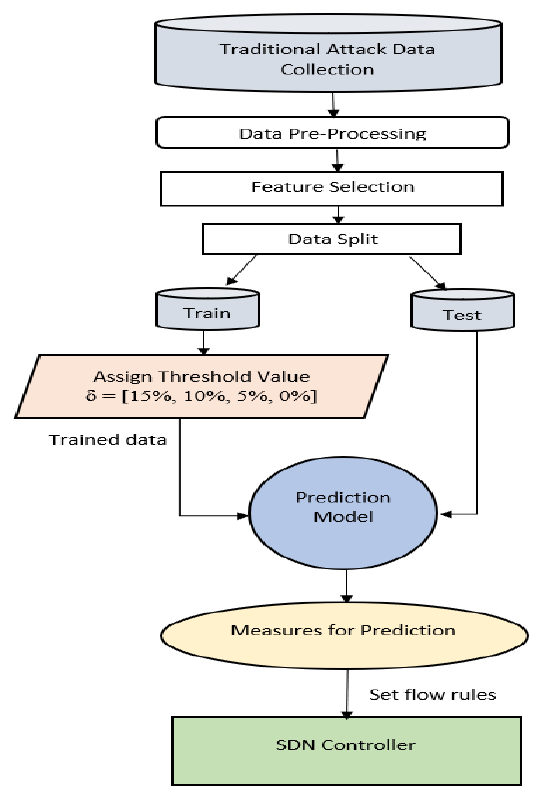
Figure 5. Framework focused on machine learning to define Stateful firewall security rules.